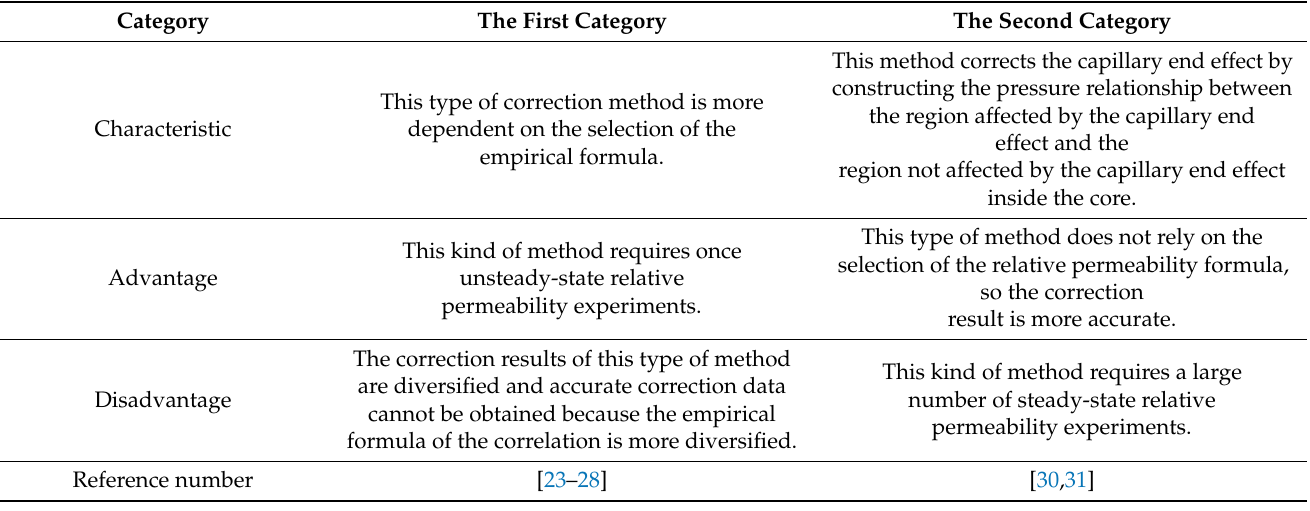
Table 1. Category of correction methods for capillary end effects.